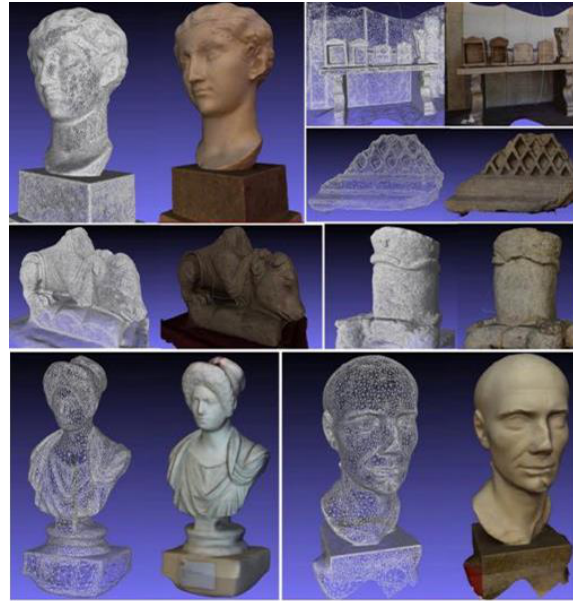
Figure 3. The results of the 3D # digitalinvasion